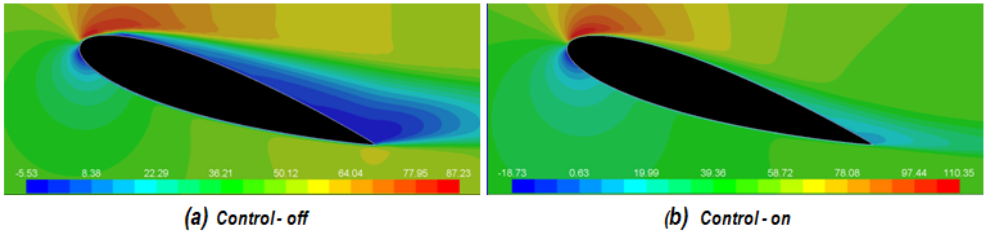
Figure 25. Contours of the x -velocity component around the NACA 0015 airfoil at AoA = 16° for ( a ) control-off and ( b ) control-on case.